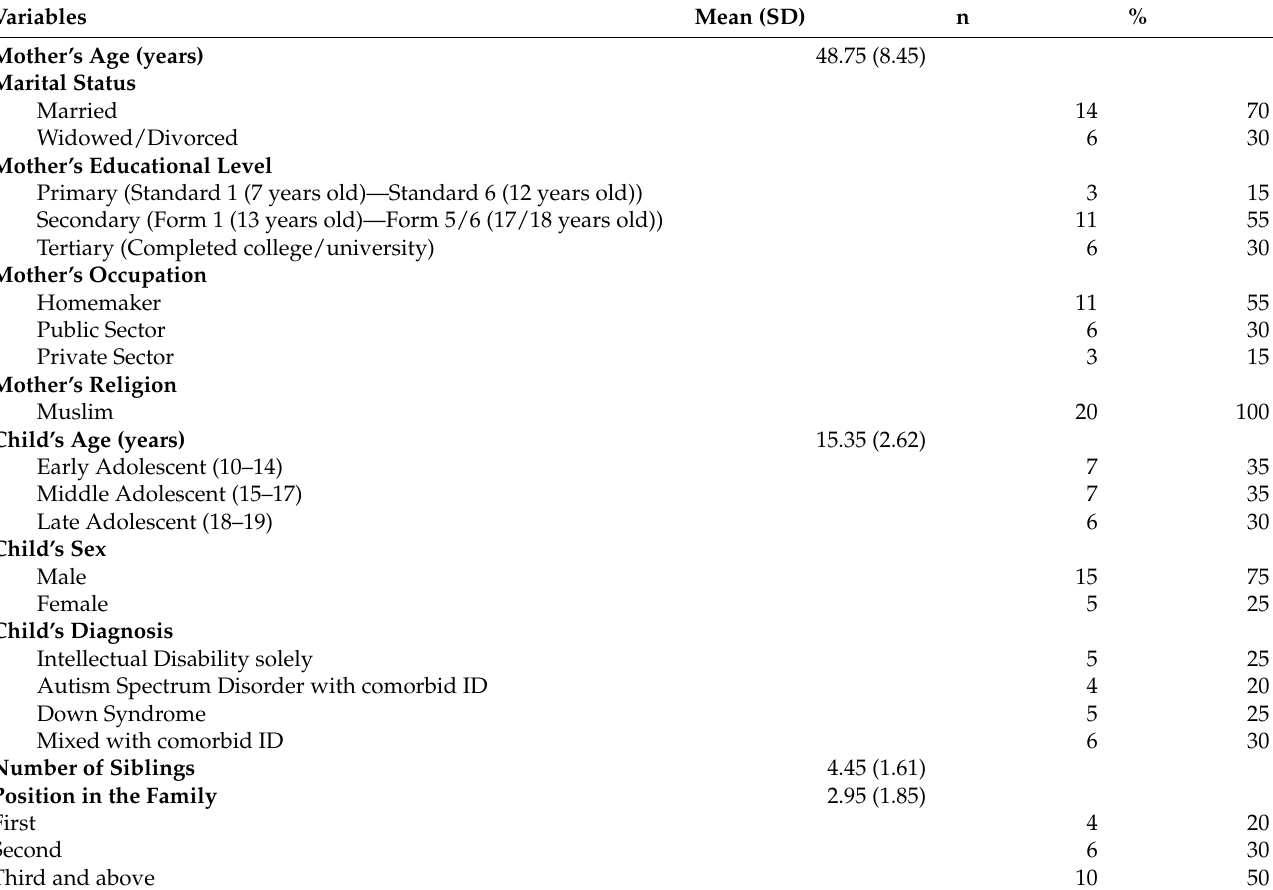
Table 2. Characteristics of the mothers and children with intellectual disabilities (n =